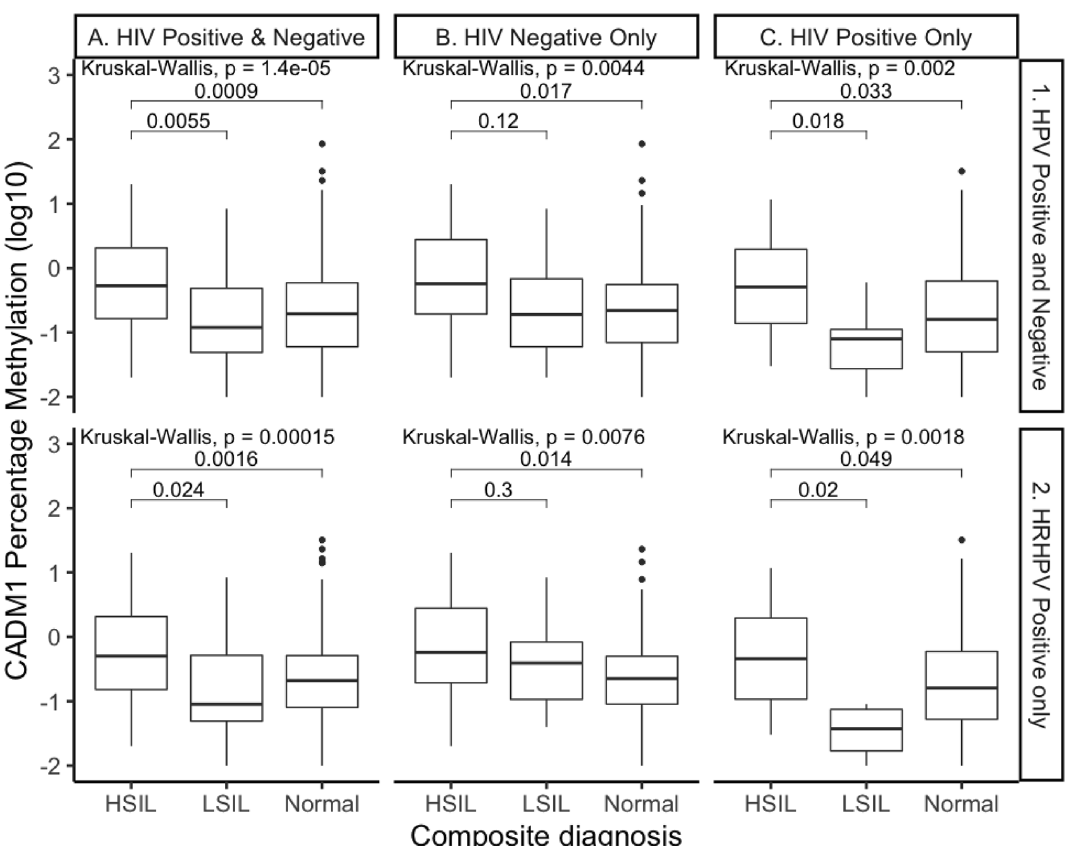
Figure 1. Percentage Methylation of gene CADM1 . All samples represented by HRHPV positivity and HIV status. Comparisons assessed by the nonparametric Wilcoxon test, with error bars corresponding to the first and third quartiles (the 25th and 75th